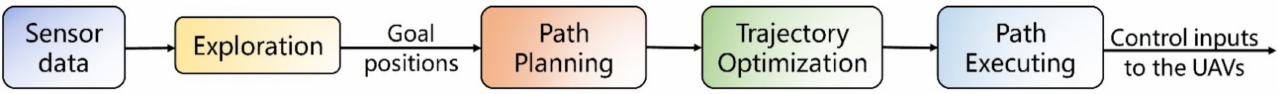
Figure 1. The procedure of autonomous navigation of UAV equipped with vision sensors in an unknown